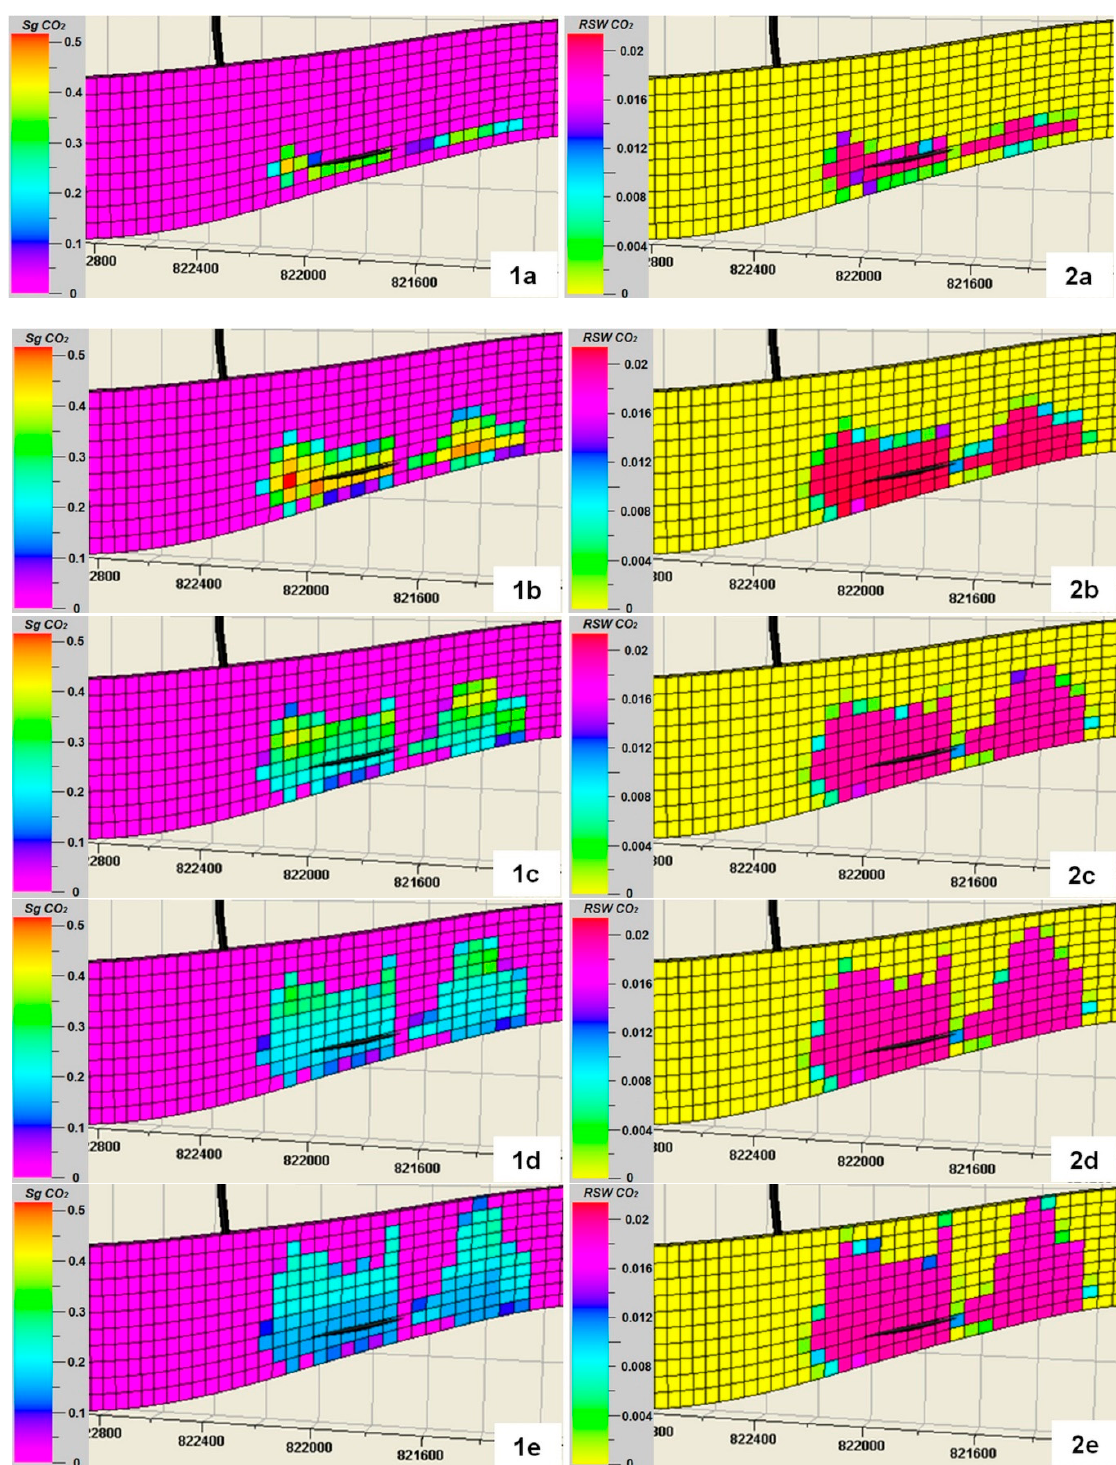
Figure 18. Free CO 2 saturation (1) and distribution of CO 2 dissolved in brine ( fraction) (2) in the injected layer of the D ę bowiec formation in the S3A simulation variant after ( a ) 5, ( b ) 25 , ( c ) 50 years from the start of injection and ( d ) 200 and ( e ) 400 years after the end of injection.